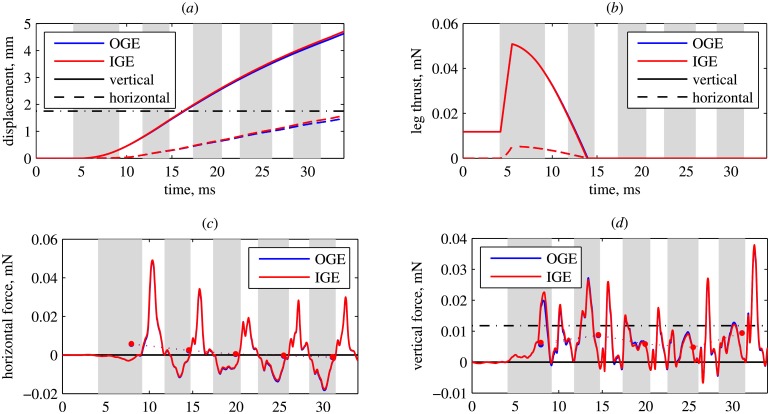
Slow takeoff.(a) Vertical and horizontal displacement. Dash-dotted line indicates zc = R. (b) Components of the leg force. (c) horizontal and (d) vertical components of the aerodynamic force. The black dash-dotted line in panel d indicates the weight. Solid circles connected by dotted lines show wingbeat cycle averages. Note that, in panels b and c, the lines for IGE and OGE almost coincide.